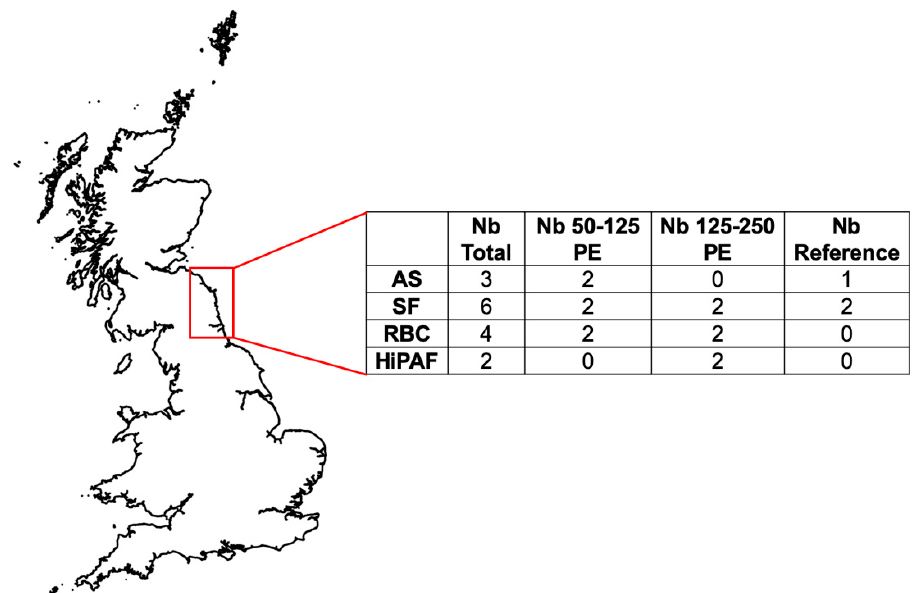
Figure 1. The number of study sites in each experimental design category and the region of study in Northeast (NE) England. Nb is the number of sites; AS is activated sludge; SF is secondary filtration (trickling filters); RBC is rotating biological contactor; HiPAF is high-performance aerated filter. Nb Reference is the number of larger, reference WWTPs (PE = 5000–10,000). Contains OS Data © Crown copyright and database right (2019).